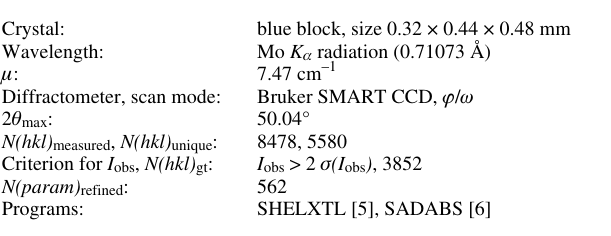
Table 1. Data collection and handling.